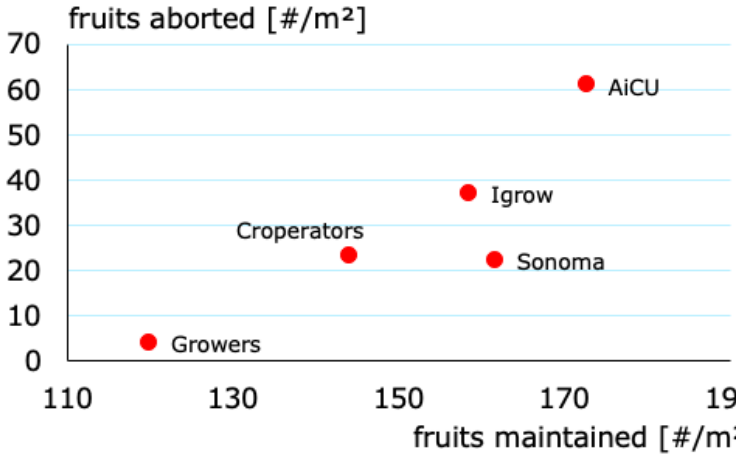
Figure 7. Number of aborted fruits and number of maintained fruits based on chosen fruit pruning strategy per team during the cucumber growing experiment.